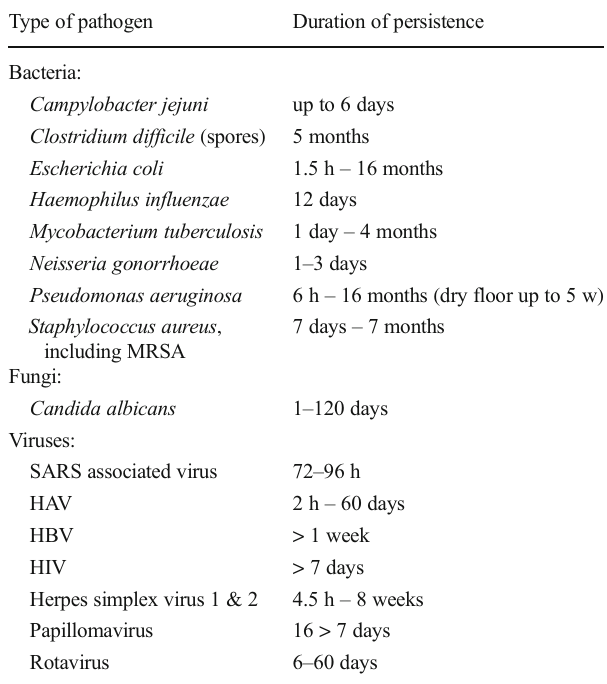
Survival of pathogens on dry inanimate surfaces (shortened from Kramer et al. BMC Infectious Diseases 2006) Type of